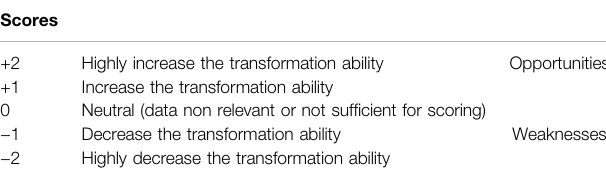
TABLE 5 | Framework for community resilience assessment based on the “ adaptive wheel ” and “ adaptive capacity assessment ” (inspired from Sansilvestri et al.,